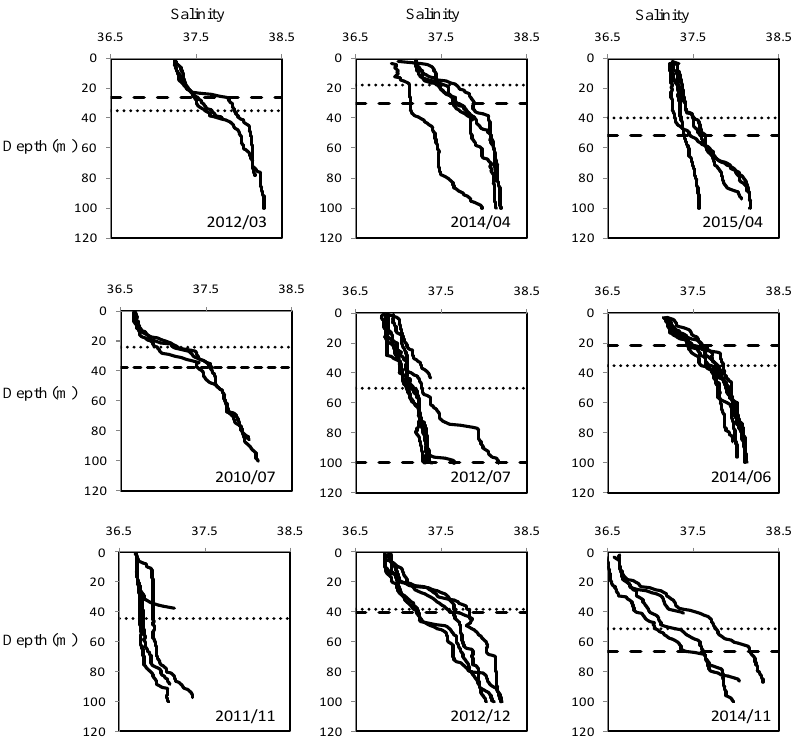
Figure 2. Vertical profiles of salinity obtained in the sampling stations in the Bay of Algeciras during the research surveys carried out from 2010 to 2015. The lower limit of mixed layer (fine dotted line) and the average position of the Mediterranean–Atlantic interface (AMI depth; thick dashed line) for each research survey are shown. Plots are grouped according to three seasonal periods: spring (top), summer (middle), and autumn (bottom).